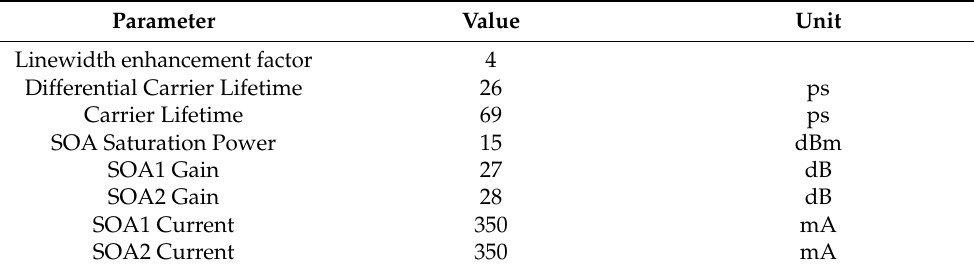
Table 1. The SOAs parameter values used in the simulation setups. Parameter Value